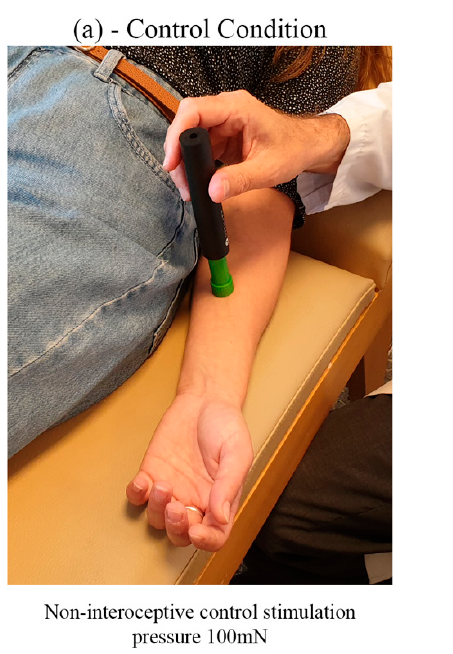
Figure 5. Stimulation procedure. ( a ) Control condition with pressure stimulation at 100 mN ( b ) experimental condition with optimal C-Tactile stimulation at 3 cm/s and with a force of 2.5 mN.